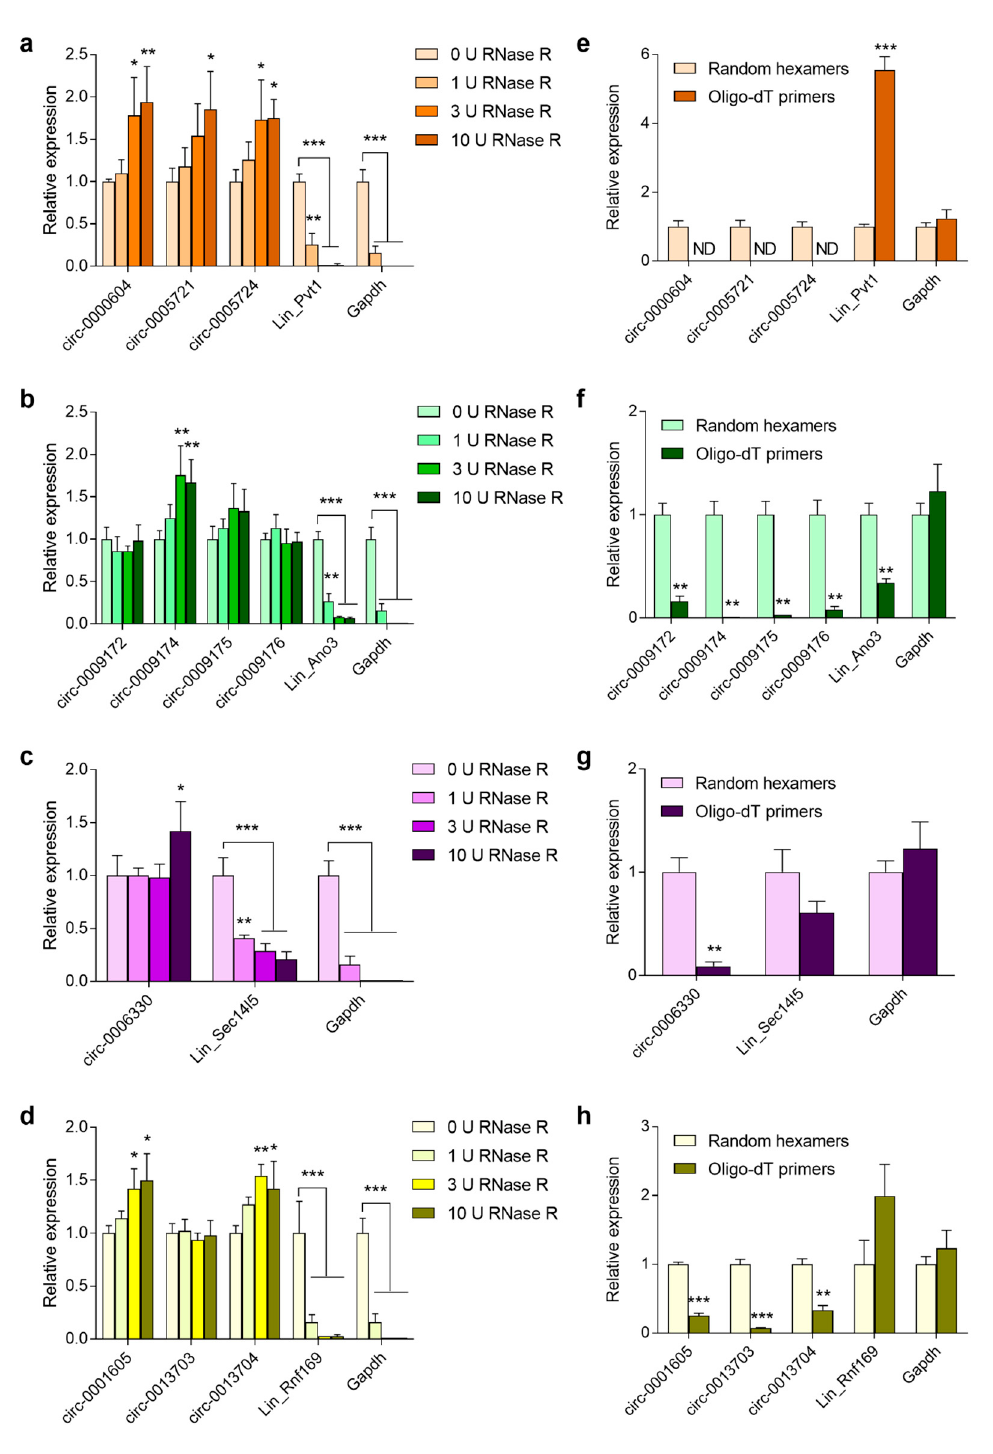
Figure 2. Experimental validation of predicted circular RNA candidates. ( a – d ) Expression of linear and circular transcript variants of Pvt1 , Ano3 , Sec14l5, and Rnf169 was assessed via RT-qPCR using divergent primers and was performed on RNaseR treated RNA samples from mouse brain at P10; ( e – h ) The RNA was reverse transcribed using random hexamer vs. oligo-dT primers. Circular transcripts are compared to their respective linear counterparts and the linear mRNA of Gapdh. Data shown are means + s.e.m. of 4 biological replicates ( n = 4) and were normalized against ( a – d ) 0 U RNaseR or ( e – h ) random hexamers. Statistics were performed using Student’s t-test with Holm–Sidak correction for multiple comparisons * p < 0.05; ** p < 0.01; *** p < 0.001. ND: Not detected.